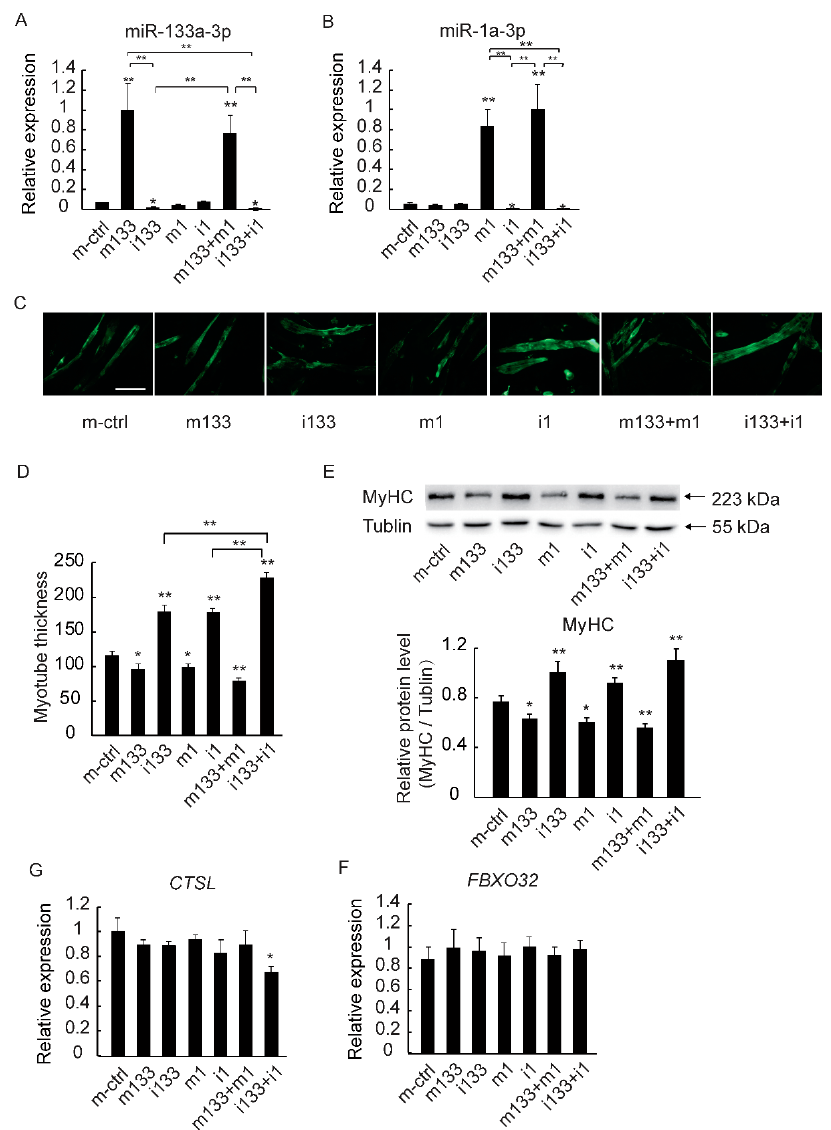
Figure 5. The downregulation of miR-133a-3p and miR-1a-3p promotes muscle growth. ( A , B ) The relative expression of miR-133a-3p and miR-1a-3p after overexpression of miRNA; ( C , D ) myotubes were placed in DM with and without GAA for differentiation for 6 days and then stained with anti-MyHC antibody. Myotube thickness was calculated (m-ctrl: mimic control; m133: miR-133a-3p mimic; i133: miR-133a-3p inhibitor; m1: miR-1a-3p mimic; i1: miR-1a-3p inhibitor); ( E ) the protein levels of total MyHC were calculated by western blotting after the overexpression of miRNA mimic; ( F , G ) the expression of marker genes of protein degradation ( CTSL and FBXO32 ) was quantified by real-time PCR. The results are expressed as mean ± S.D. of three independent experiments. * p < 0.05; ** p < 0.01 compared with the negative control (on the bars) or between the indicated groups (Tukey’s post-hoc test).